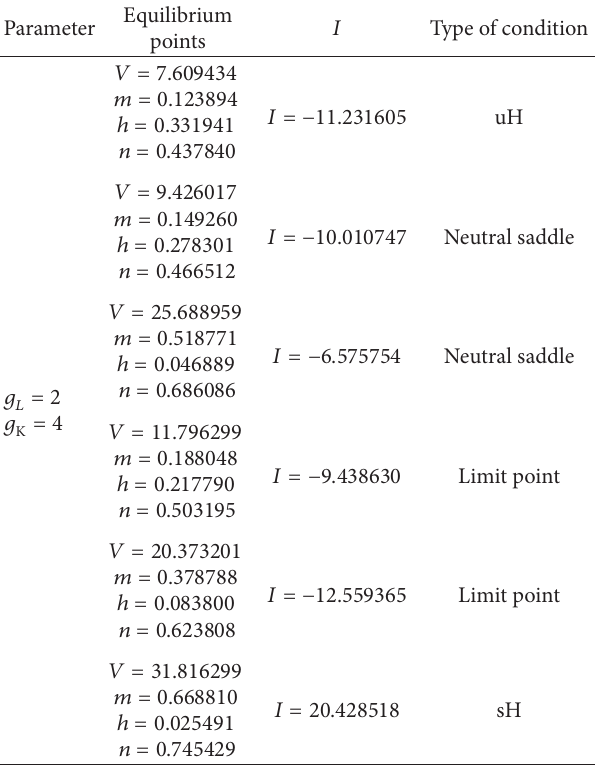
coefficient is positive, and there are two eigenvalues with Re 𝜆 1,2 ≈ 0 , Im 𝜆 1 ̸= 0 ; then at the Hopf bifurcation point, HH is unstable, and there is an unstable limit cycle, so it is the subcritical Hopf bifurcation (uH). Although the equilibrium points of the second and fifth are labelled as H, they are not Hopf bifurcation points. They are neutral saddle point, where